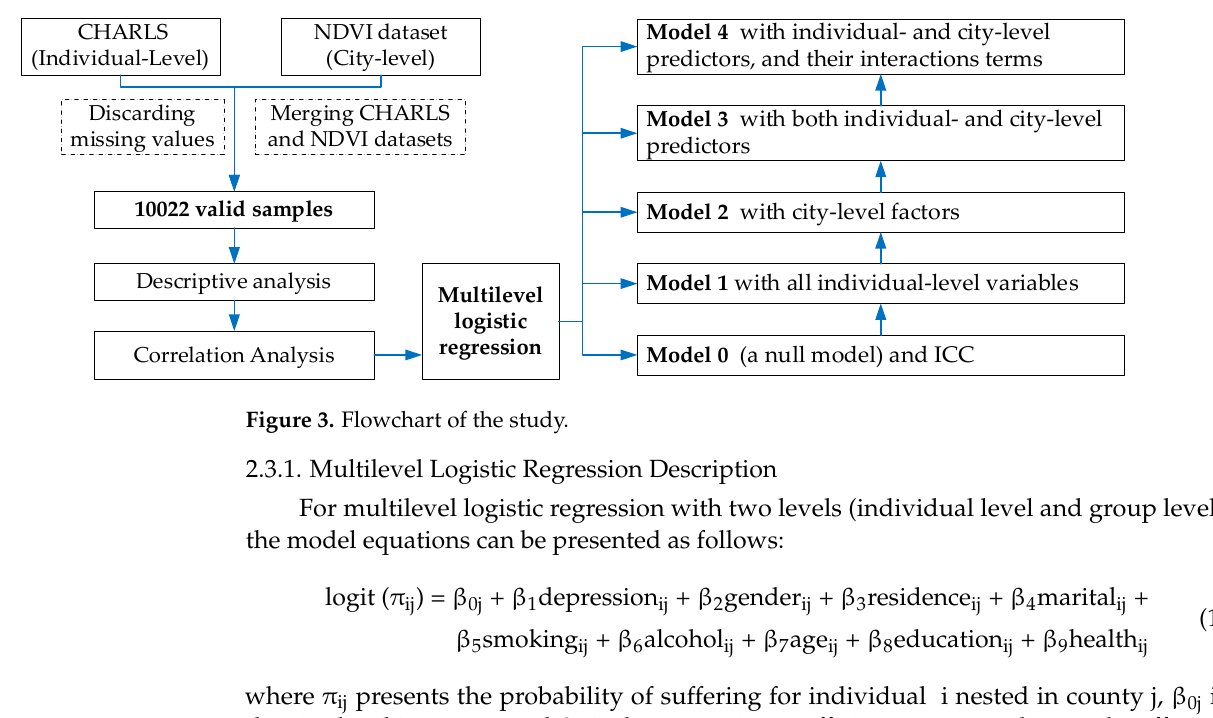
Table 1. Descriptive analysis (N = 10,022).